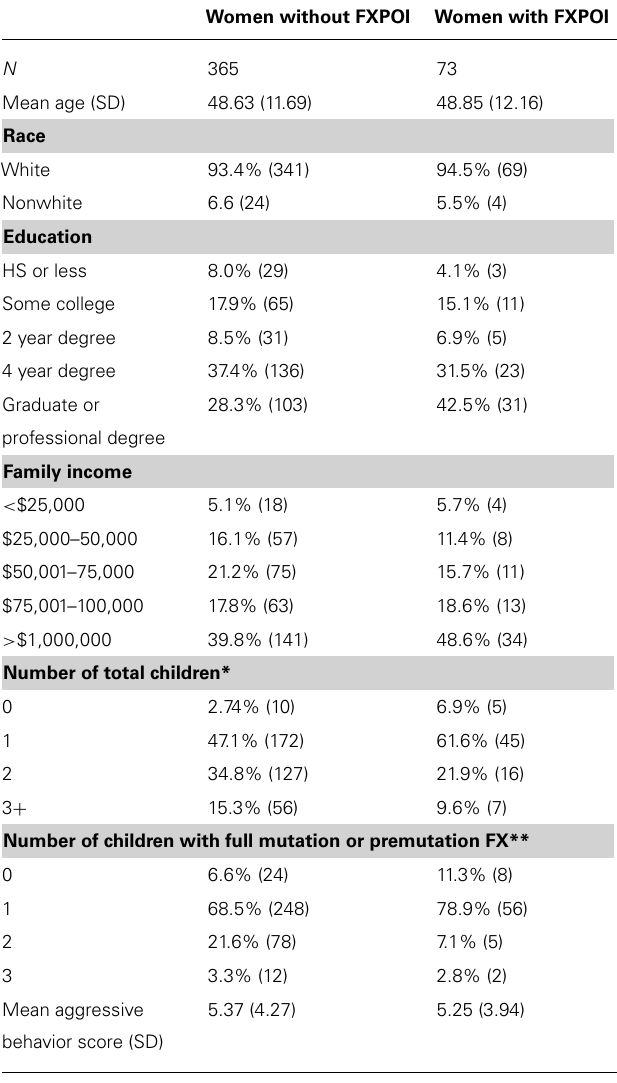
Table 1 | Demographics of the sample with and without